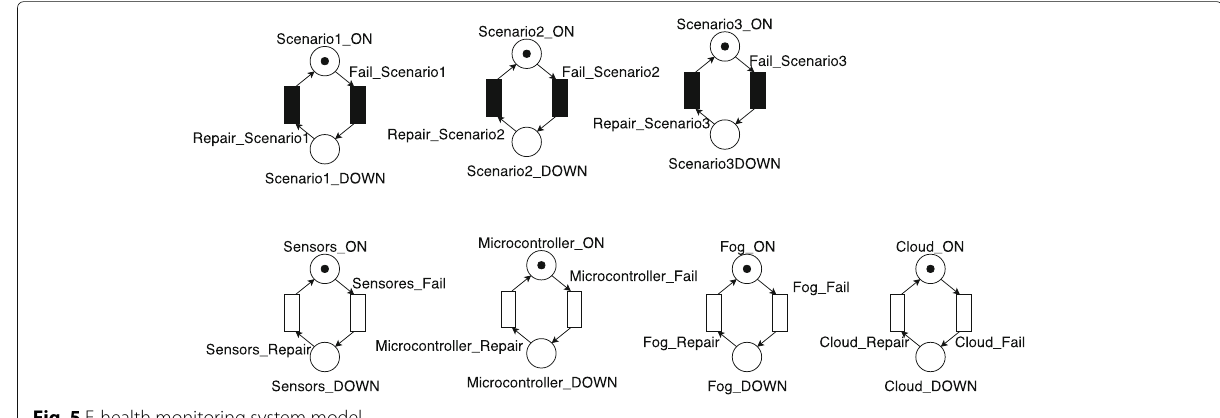
Fig. 5 E-health monitoring system